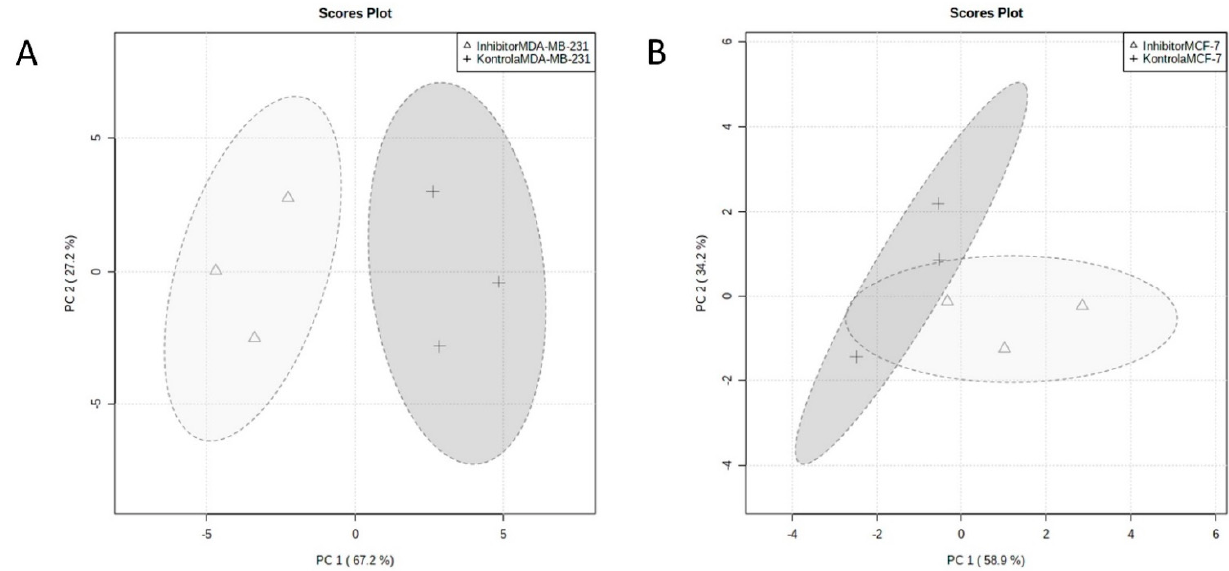
Figure 7. PCA of metabolic profile of MDA-MB-231 and MCF-7 cells. Notes: PCA of metabolic profile of MDA-MB-231 ( A ) and MCF-7 cell lines ( B ) after treatment with compound 1 in duration of 48 h. PCA, principal component analysis. Table 1. List of identified compounds in the MDA-MB-231 and MCF-7 cell